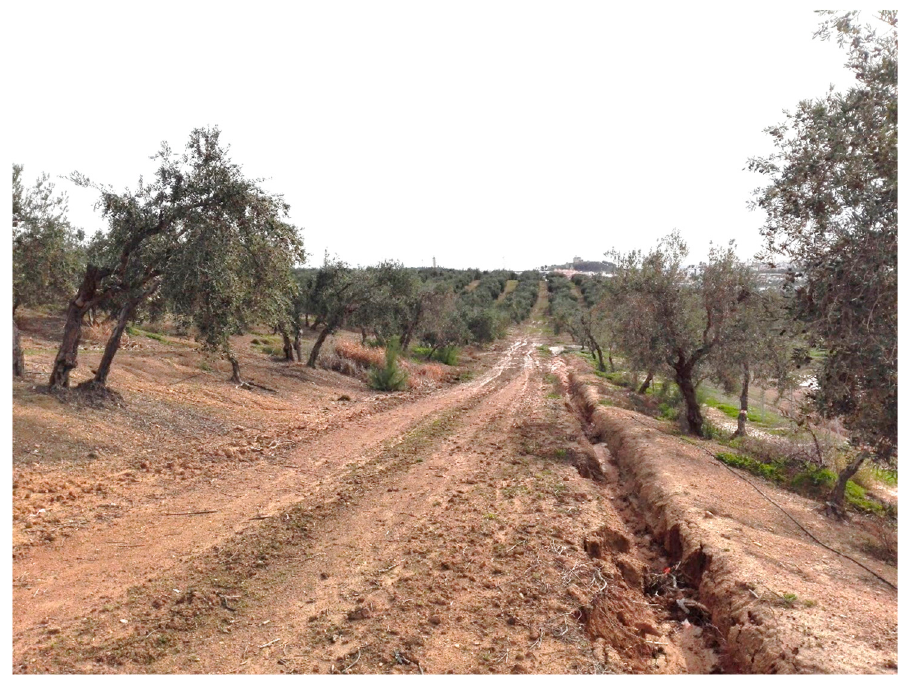
Figure 10. Waterlogging in the lower area of transect T1 A–B (Figure 9). The photograph is taken looking toward point B.